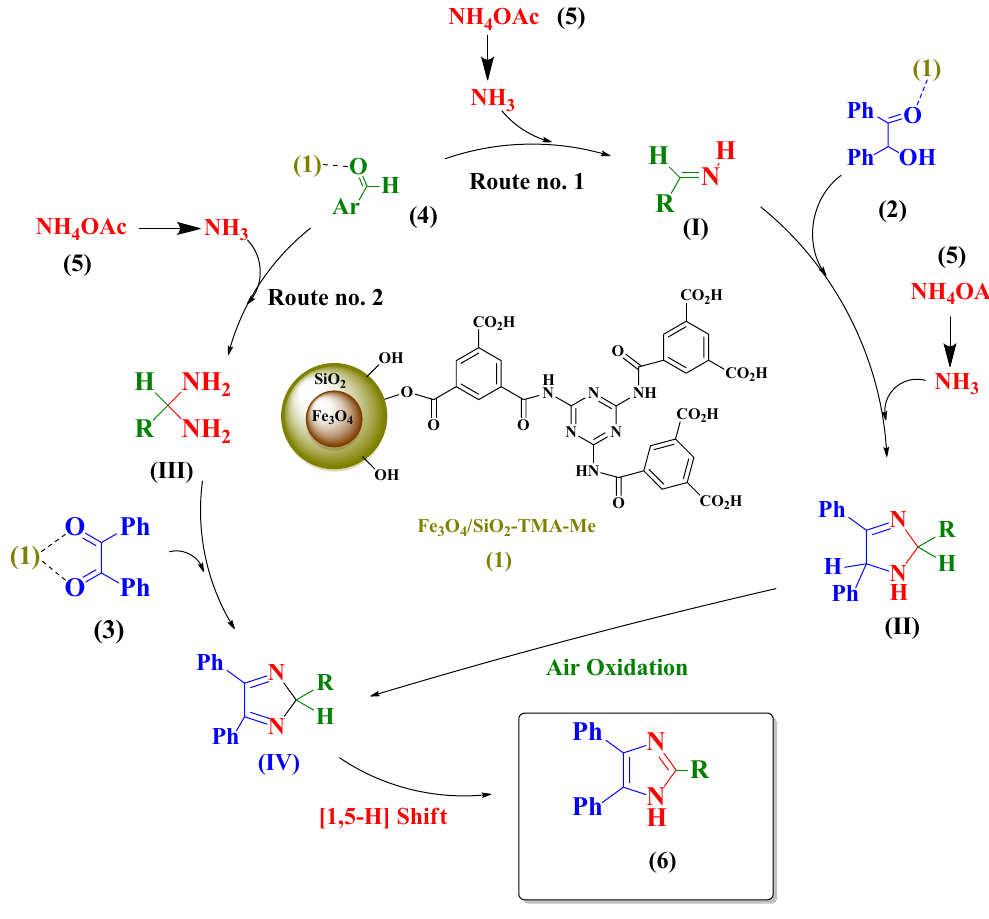
Figure 9. Plausible mechanism for the imidazole derivatives synthesis catalyzed by the nanocomposite Fe 3 O 4 / SiO 2 -TMA-Me nanocomposite ( 1 ).